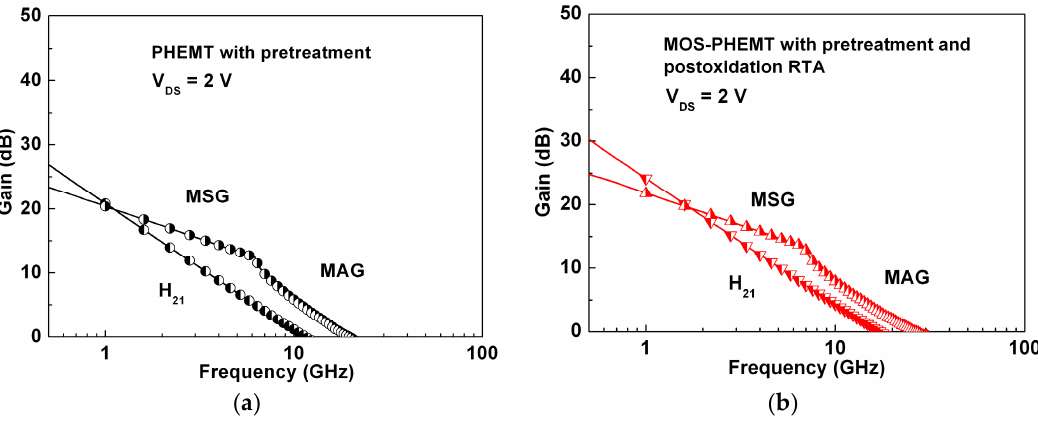
Figure 7. Comparison of microwave characteristics at maximum g m for: ( a ) referenced PHEMT; and ( b ) MOS-PHEMT.